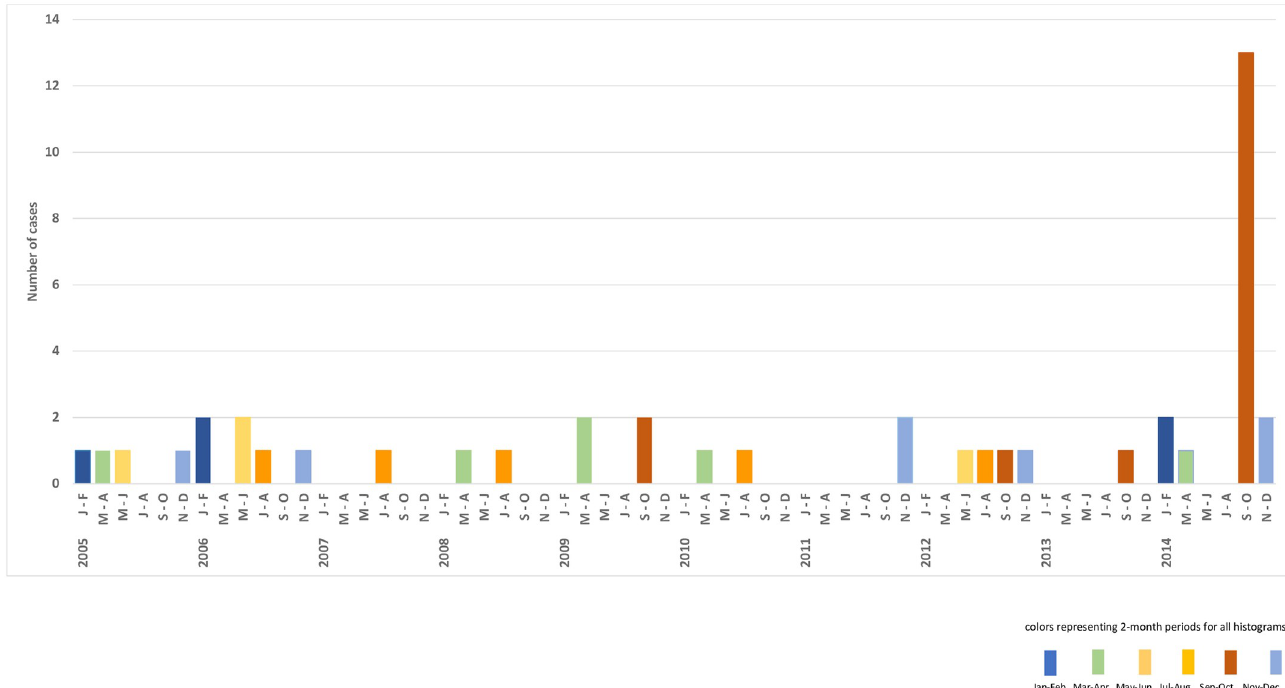
Fig 3. Number of AFM cases by 2-month periods, 5 sites